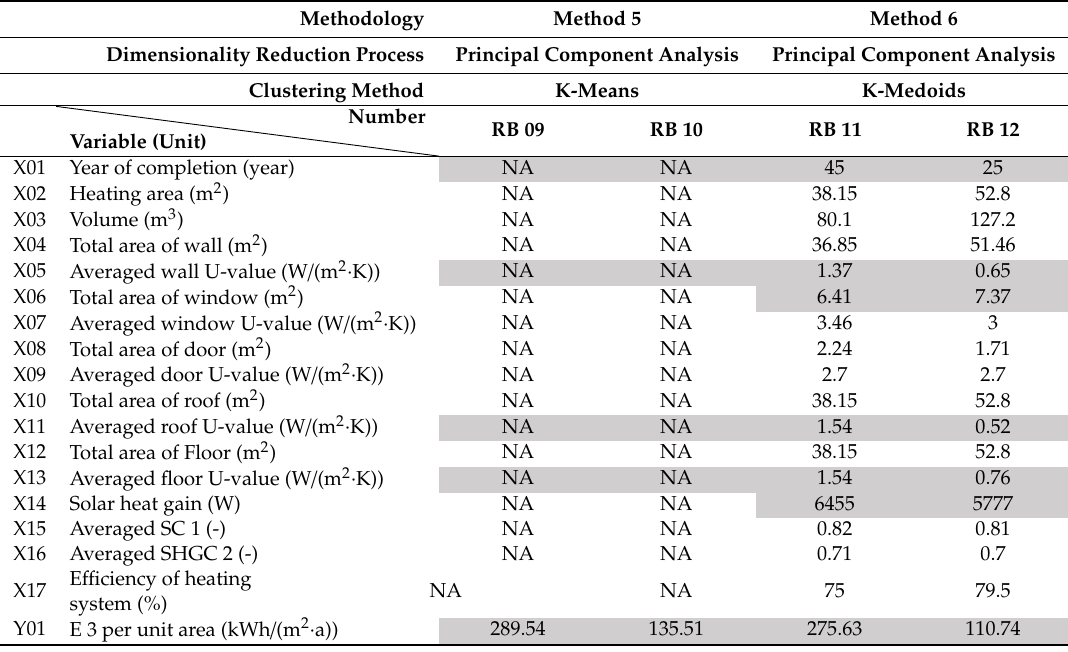
Table 7. Standard model derived through methods 5 and 6.